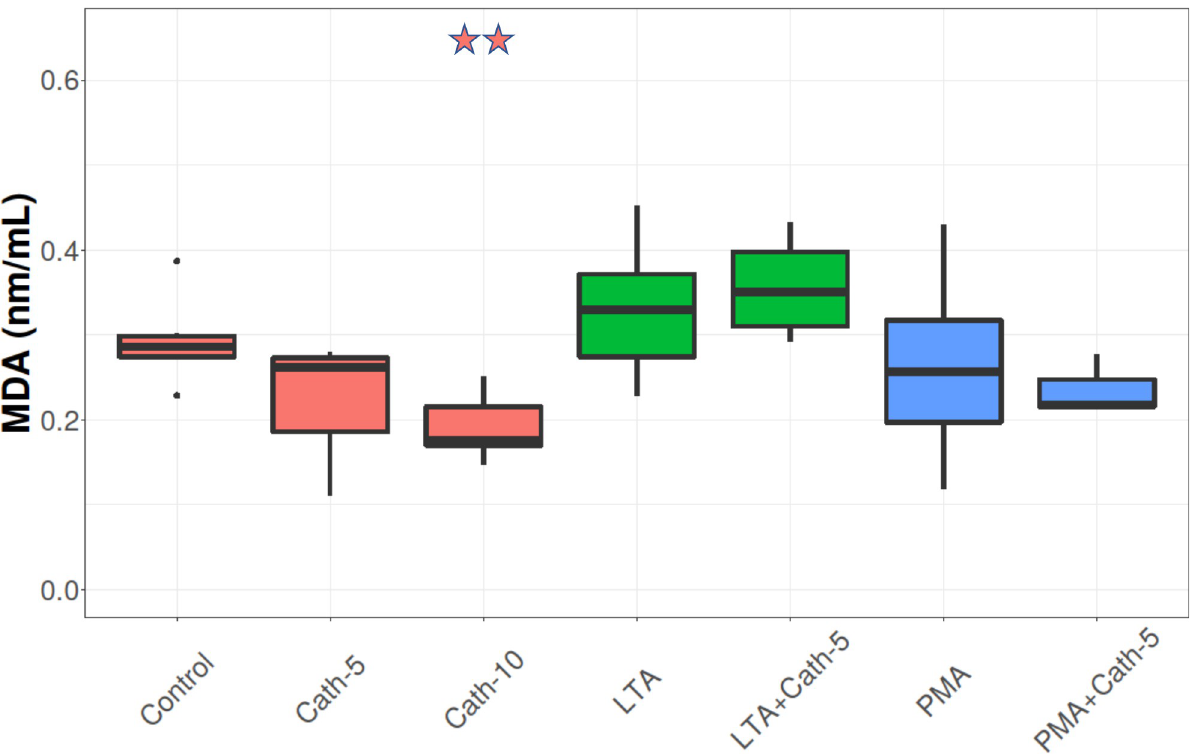
Fig 8. MDA concentration. Boxplots showing the malondialdehyde (MDA) concentration for hepatocyte—non-parenchymal cell co-cultures treated with chicken cathelicidin-2 (Cath), lipoteichoic acid (LTA), or phorbol myristate acetate (PMA) only, or the combination of Cath and LTA or PMA (n = 6/group). Results are displayed as nmol/mL. Cath-5 = 5 nmol/mL Cath, Cath-10 = 10 nmol/mL Cath, LTA = 50 μ g/mL Staphylococcus aureus LTA, PMA = 1000 ng/mL PMA. The Control refers to absolute control cells that received none of the treatments. Red asterisks over the boxes refer to significant differences compared to control cells, green asterisks to the group treated only with LTA, blue asterisks to the group treated only with PMA, and black asterisks between the two concentrations of Cath. � p < 0.05, �� p < 0.01.